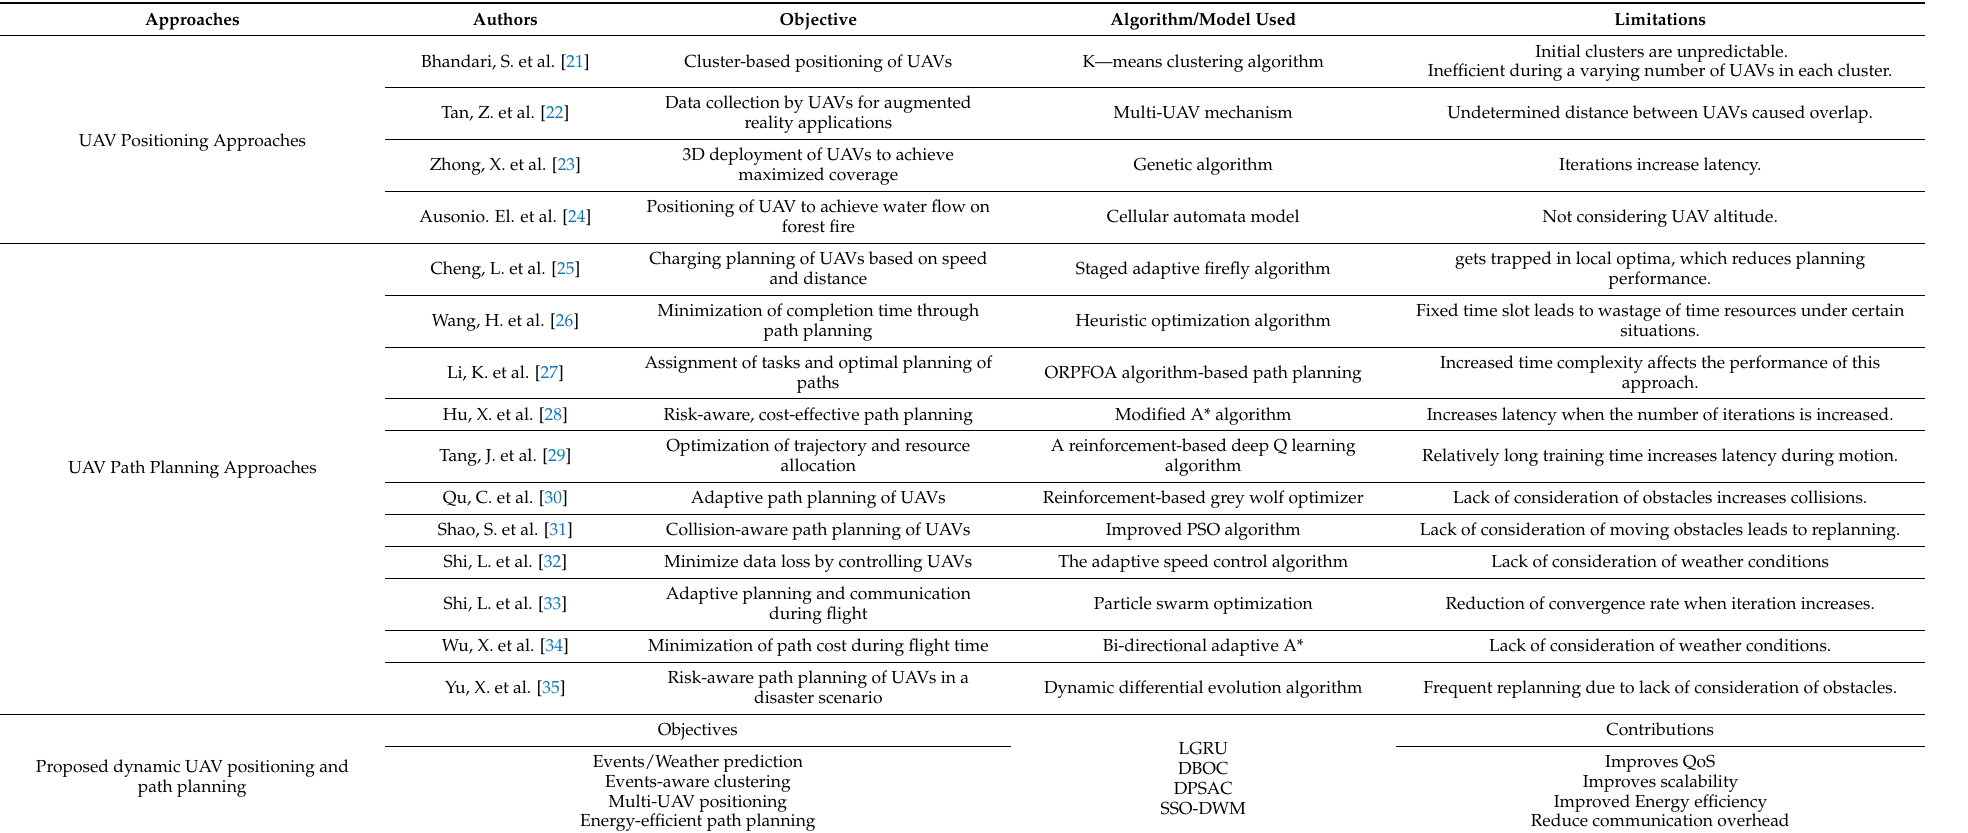
Table 1. Summary of literature